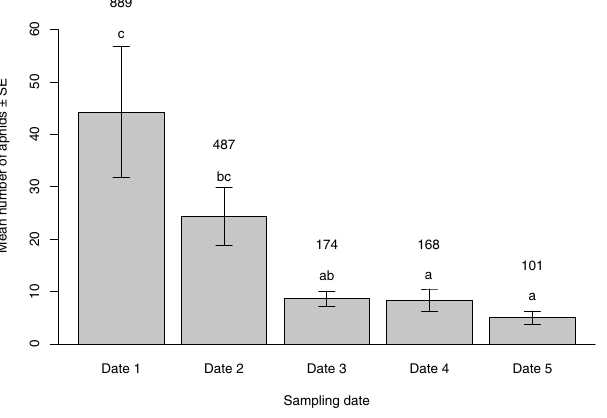
Figure 1. Mean number of Sitobion avenae aphids ( ± standard error (SE)) per each sampling date in 20 fields with 60 wheat tillers per field per each sampling date: date one (16 th October), date two (4 th November), date three (13 th November), date four (26 th November) and date five (10 th December). Numbers on each column indicate the total aphid abundance per sampling date and different letters indicate statistical differences at p <